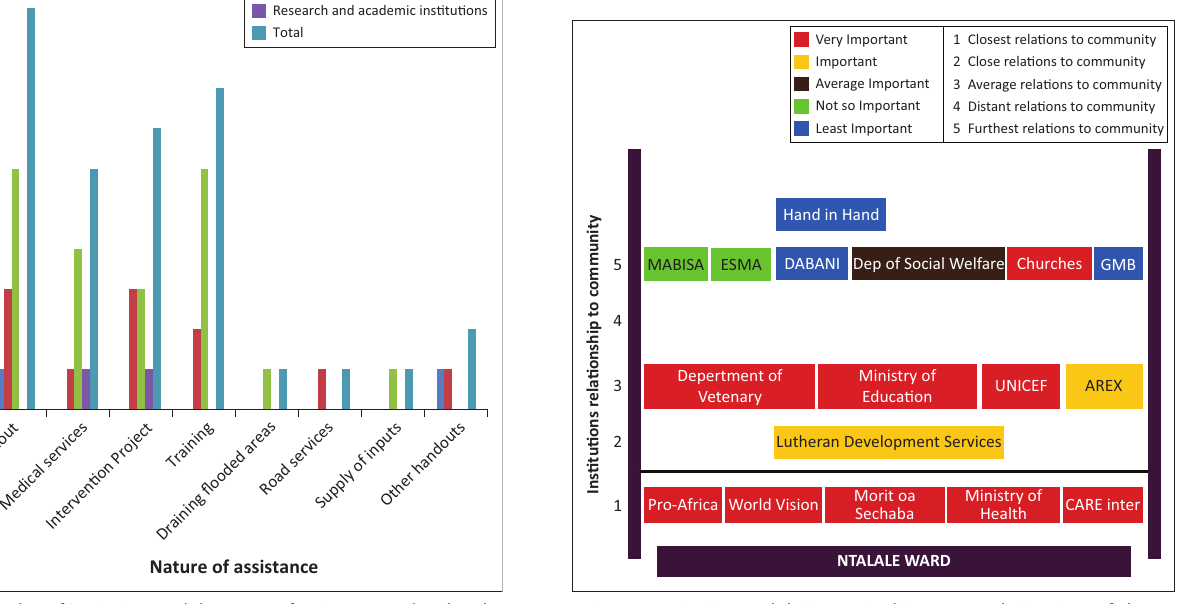
FIGURE 4: Institutions and their perceived importance during times of climate change-related stress, and social distance to the